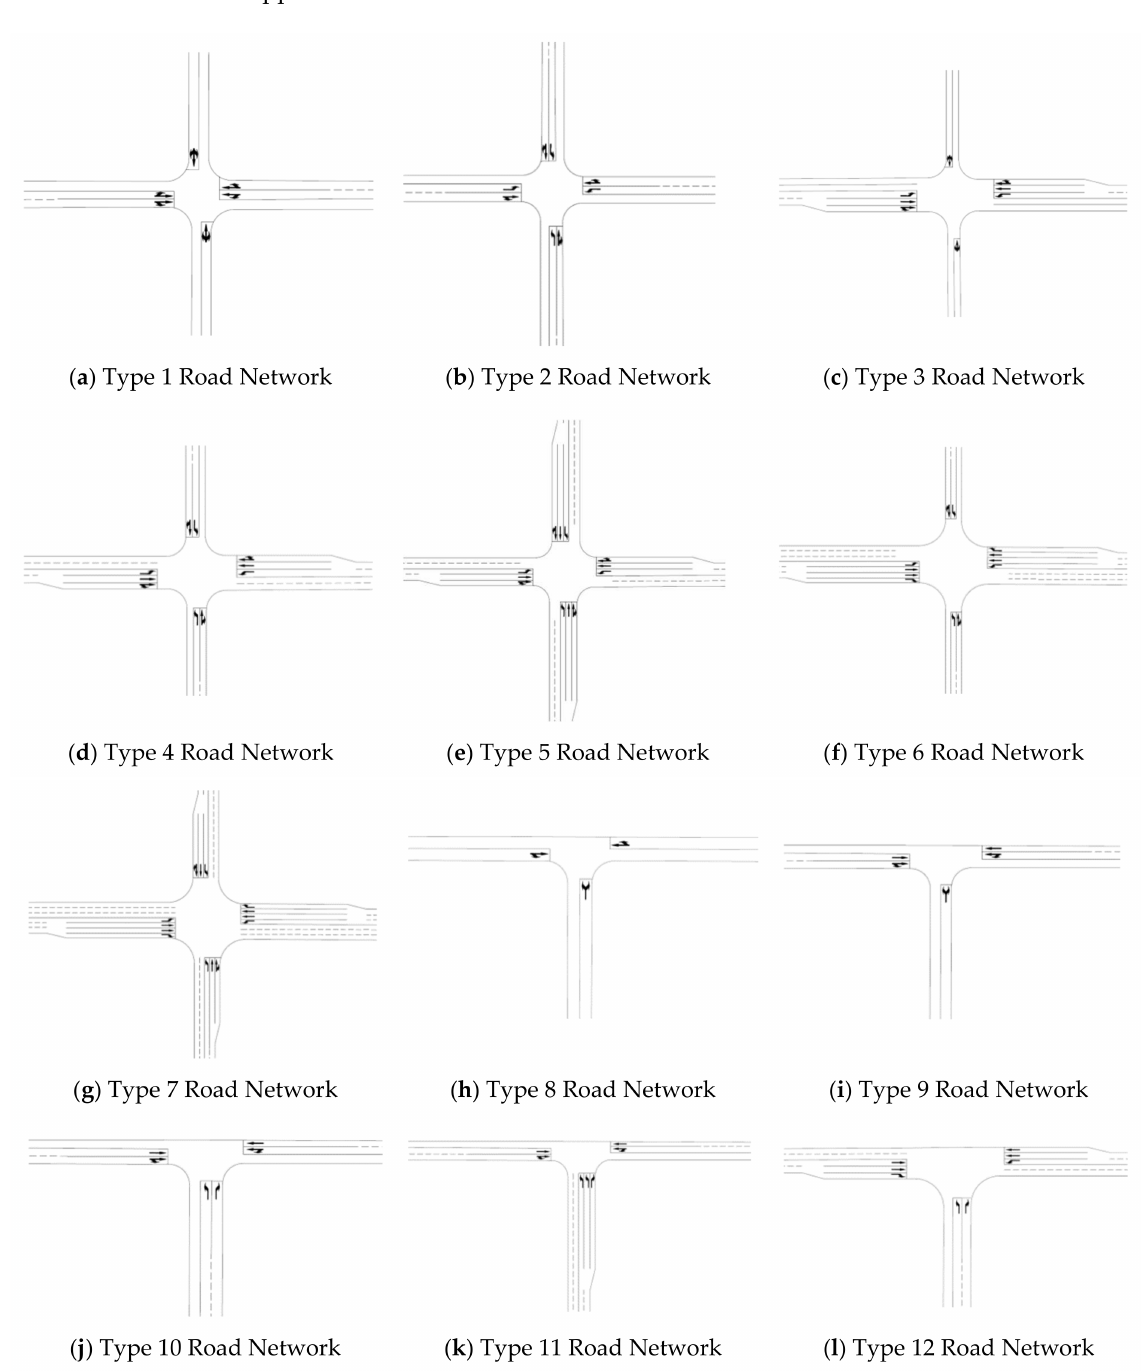
Figure 2. Definitions for twelve types of basic road networks. ( a ): Type 1 Road Network, ( b ): Type 2 Road Network, ( c ): Type 3 Road Network, ( d ): Type 4 Road Network, ( e ): Type 5 Road Network, ( f ): Type 6 Road Network, ( g ): Type 7 Road Network, ( h ): Type 8 Road Network, ( i ): Type 9 Road Network, ( j ): Type 10 Road Network, ( k ): Type 11 Road Network, ( l ): Type 12 Road